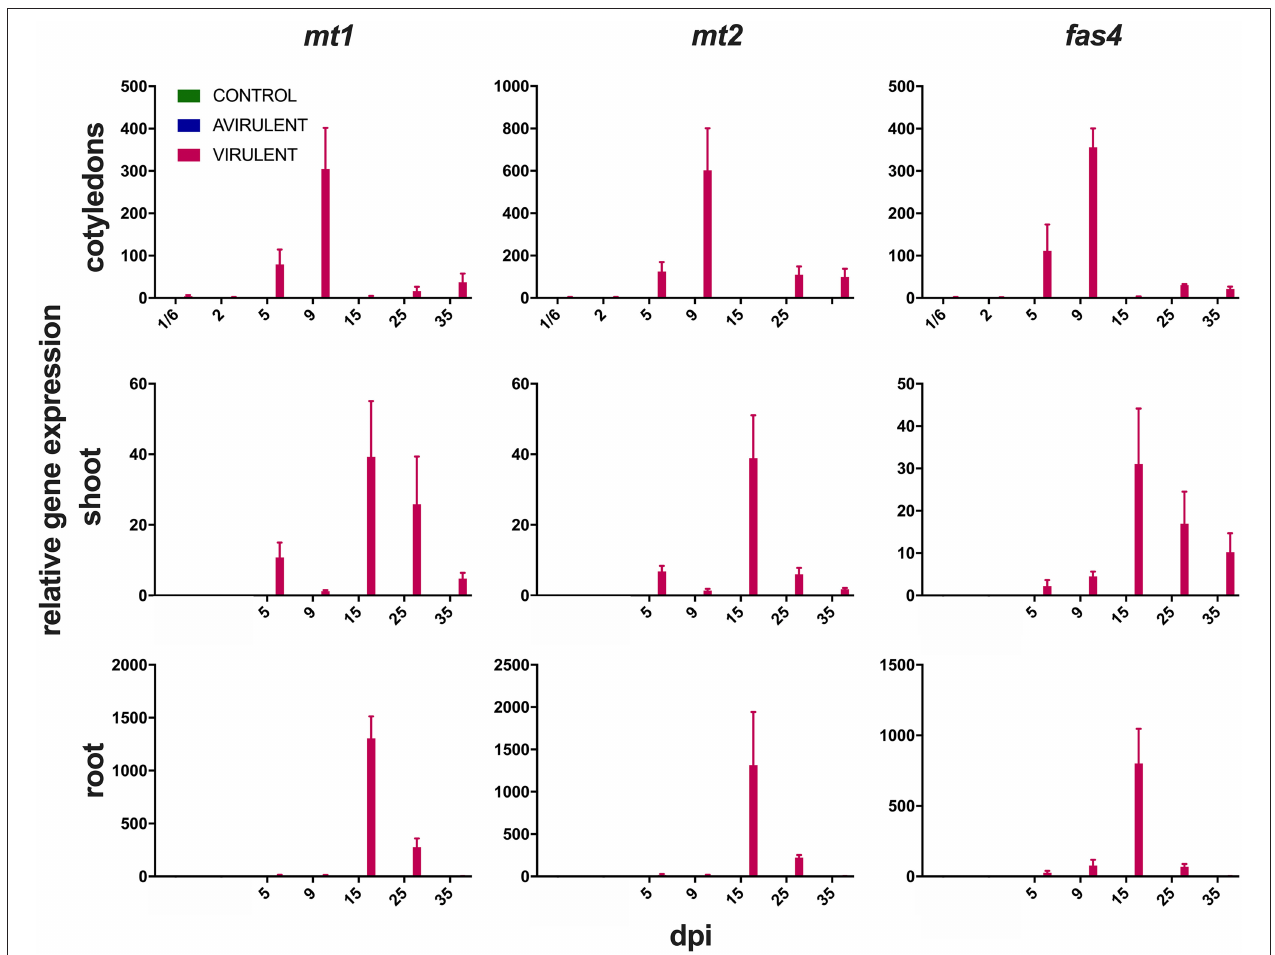
FIGURE 3 | Expression of mt1, mt2, and fas4 in cotyledons from 4h post-inoculation ( 1 / 6 days post-inoculation; dpi) to 35 dpi, and in shoots and roots from 5 to 35 dpi following seed inoculation with either virulent R. fascians strain 602, avirulent strain 589, or mock inoculation. Relative fold changes were calculated using GAPDH and 18S rRNA as internal reference genes. The error bars are ± 1s.d. of two independent experiments.